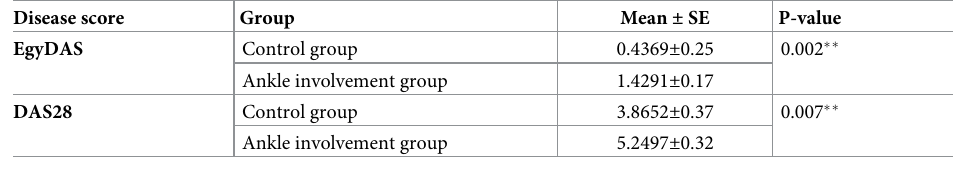
Table 5. Mean ± standard error of the mean (SE) of the EgyDAS and DAS28 scores for the control group (patients without ankle involvement, n = 23) and ankle involvement group (n = 32) along with the p-value of the indepen- dent samples t-test.